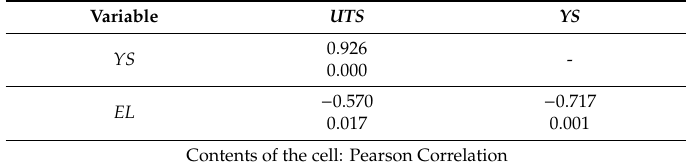
Table 5. Pearson correlation test between the response